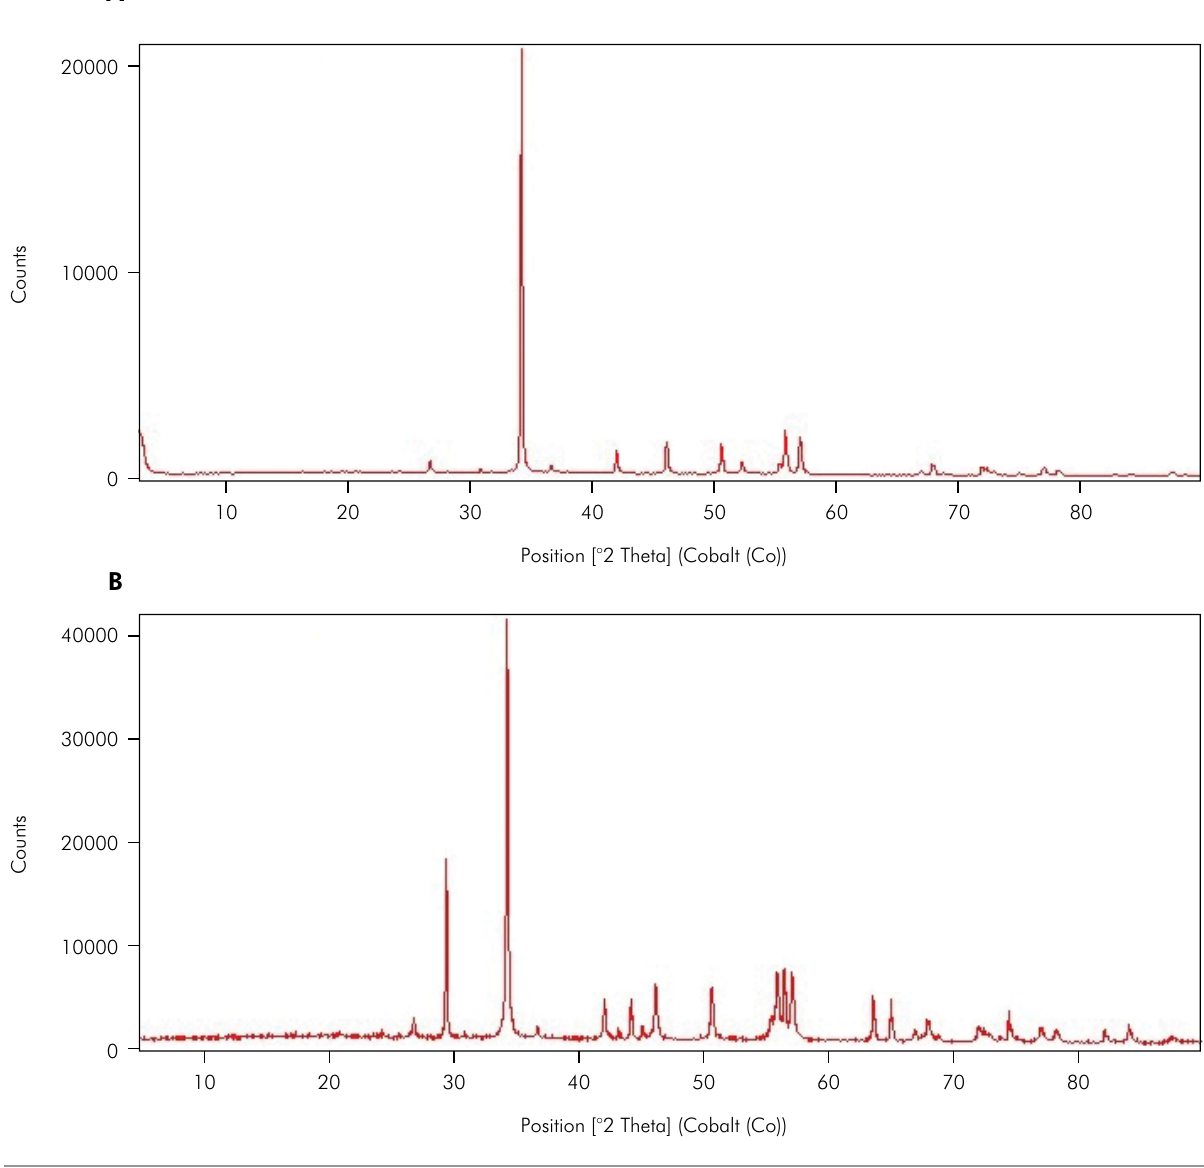
Figure 1. XRD pattern of (A) eggshell powder; (B) EB@TiO